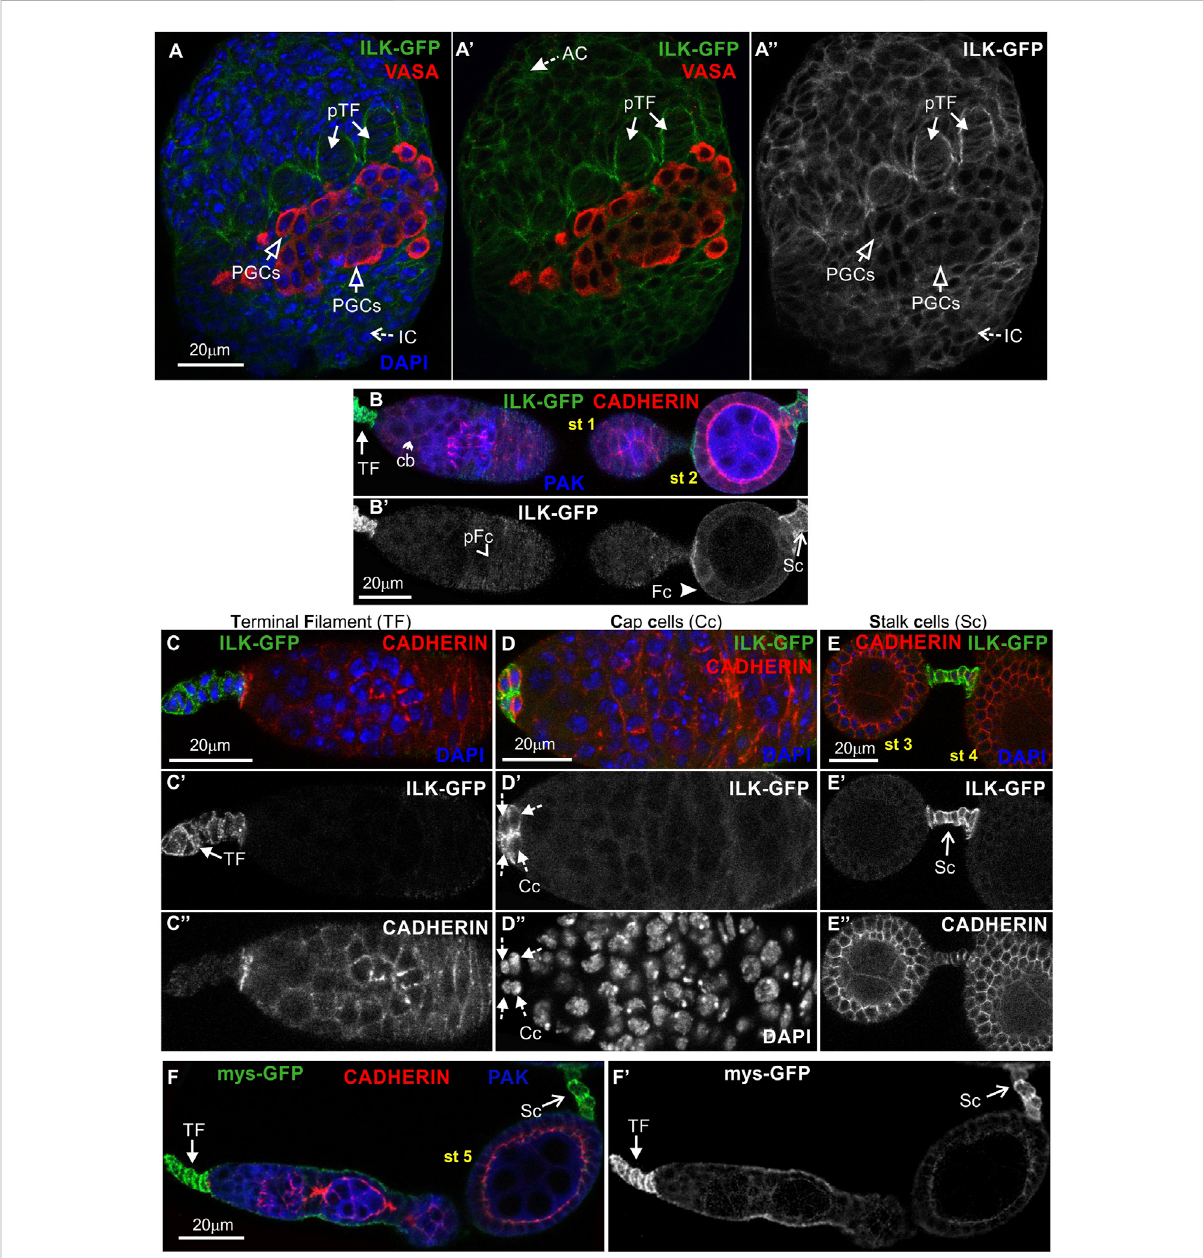
FIGURE 4 ILK-GFPexpressioninthedevelopingovaryandtheadulteggchamber.Confocalmicrographsofovarioles andeggchambersexpressingGFP- tagged ILK and β PS integrin ( mys ) reveal their endogenous protein expression and subcellular distribution. (A-A") Early pupal (2 – 4h APF) ovary expressing ILK-GFP. The protein is enriched in the lateral sites of terminal fi lament cell precursors and in the periphery of interstitial cells, apical cells andprimordialgermcells.PGCsweremarkedwithantibodiesagainstVasa. (B-B ’ ) ILK-GFPexpressionintheearlyprevitellogeniceggchambers of an adult ovariole shows (B-B 9 ) low level of protein expression in pre-follicle and follicle cells, but signi fi cant enrichment in the periphery of (C-C") terminal fi lament cells, (D-D") cap cells in the germarium region and (E-E") in the interfollicular stalk cells. Co-staining against Cadherin and PAK proteinsshowsforILK-GFPaclearlydistinctpatternofexpressionandlocalizationfromtheepithelialandgermcelllineages. (F-F 9 ) mys - GFP ishighly accumulated in terminal fi lament and stalk cells, similar to Parvin-GFP and ILK-GFP. Each image is representative of at least fi ve different imaged ovarioles of the same genotype and markers used. AC, apical cells; pTF, precursor of terminal fi lament; TF, terminal fi lament; PGCs, primordial germ cells; IC,interstitial cells; Cc, capcells; cb,cystoblast; glc, germline cyst; pFC, pre-follicle cells;Fc, follicle cells;Sc, stalk cells. Scalebars:20 μ m inall